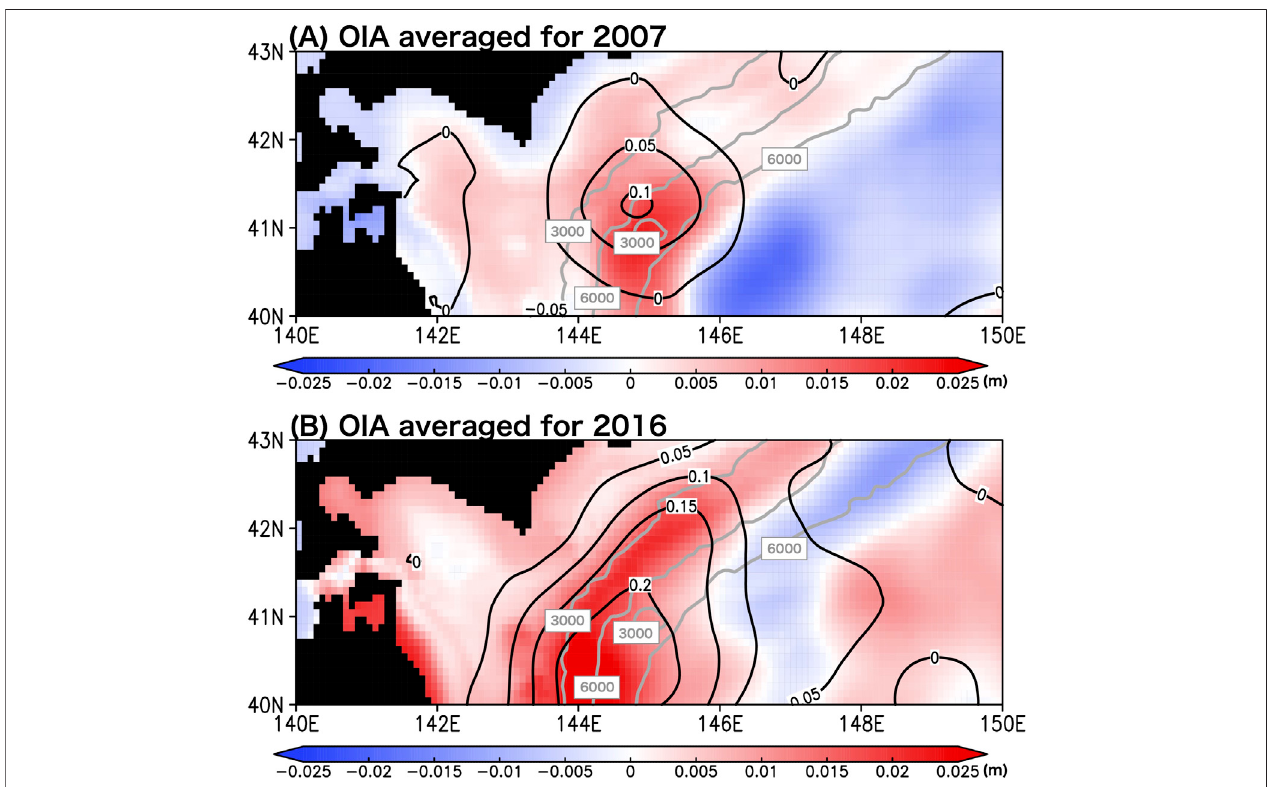
FIGURE6|(A) Spatialdistribution oftheyearlyaveragedOIAfortheyear2007(shadedcolor).TheyearlyaveragedSSHanomaliesfortheyear2007areshownby black contours. The unit is m. The bottom depths of 3000 and 6000 m are shown by the gray solid contours. (B) Same as (A) but for the year 2016.